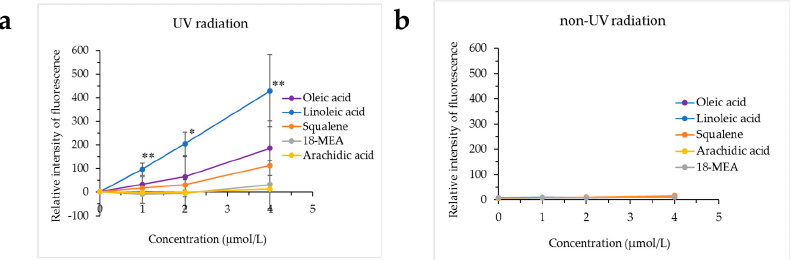
Figure 4. Confirmation of the production of hydroxy radicals from lipids exposed to UV radiation.